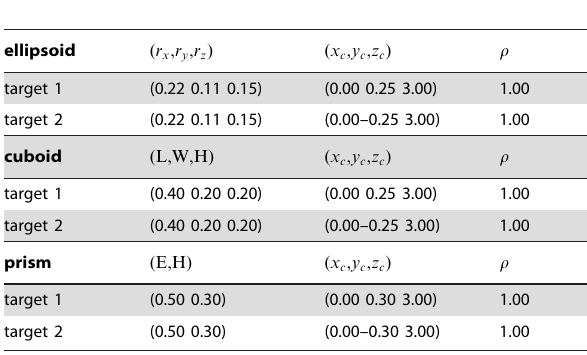
Table 1. Parameters for inclusions with various shapes.